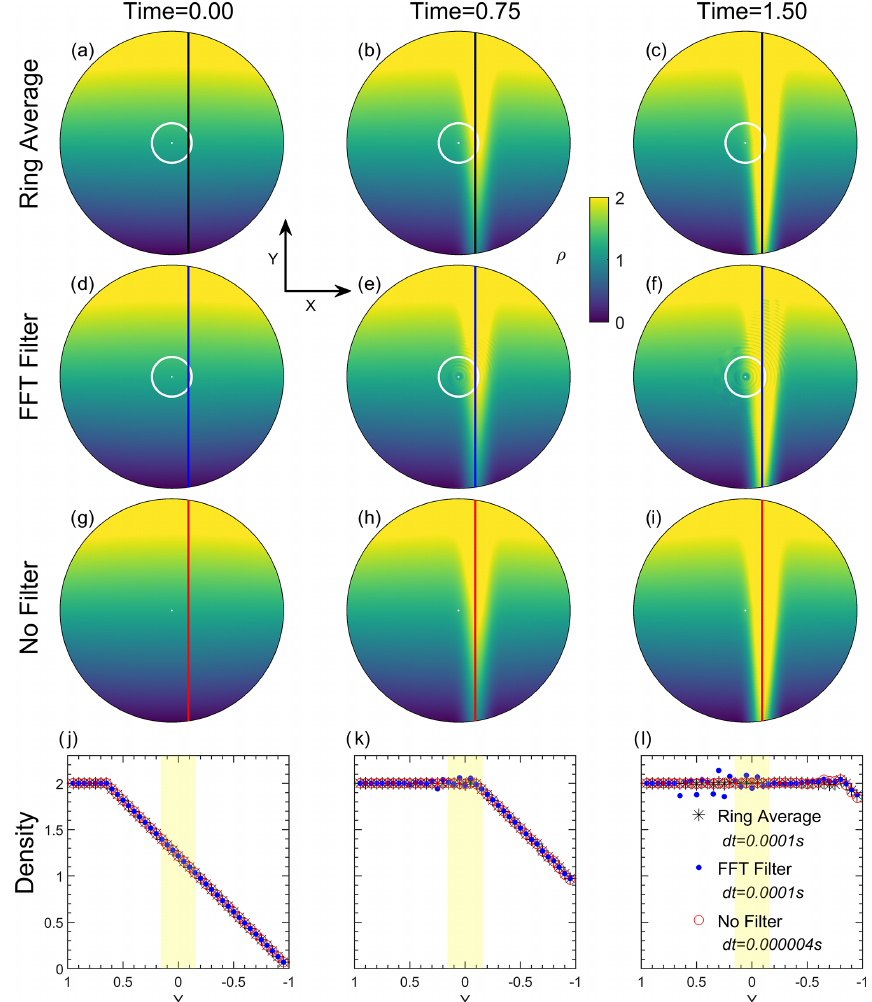
Figure 4. The distribution of density at three simulation snapshots ( t = 0, 0.75, and 1.5). The first three panels from the top show the results with the ring average technique, with an FFT filter, and without any filter. The latitude boundaries of the ring average and FFT filter are marked by white circles in the upper two panels. The bottom panels show the comparison of distributions of density along the line x = 0 . 15 (star) with the ring average technique, (blue dot) with an FFT filter, and (red circle) without a filter at the three snapshots. The number of averaging chunks for the ring average technique in each azimuthal ring near the pole is set to be [18 18 18 18 36 36 36 36 72 72 72 72 144 144 144